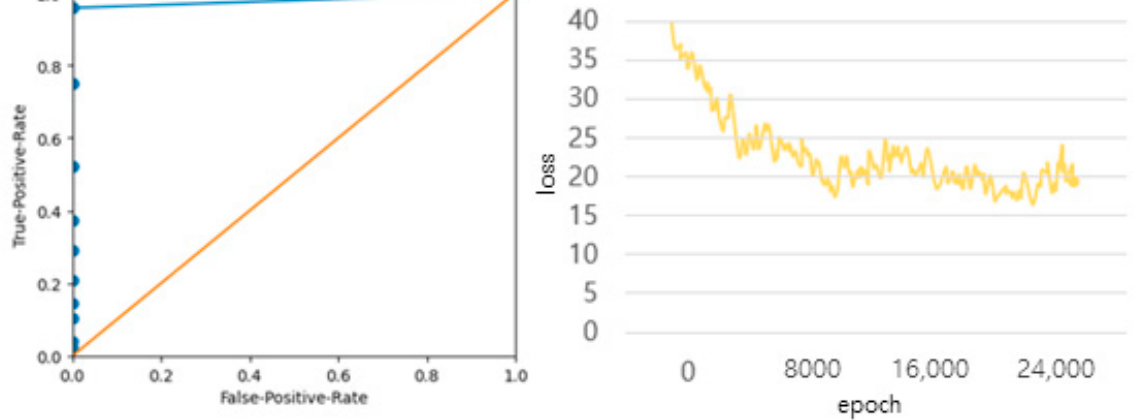
Figure 18. ROC curves and joint data learning loss curves for 50 joint angle data based on error